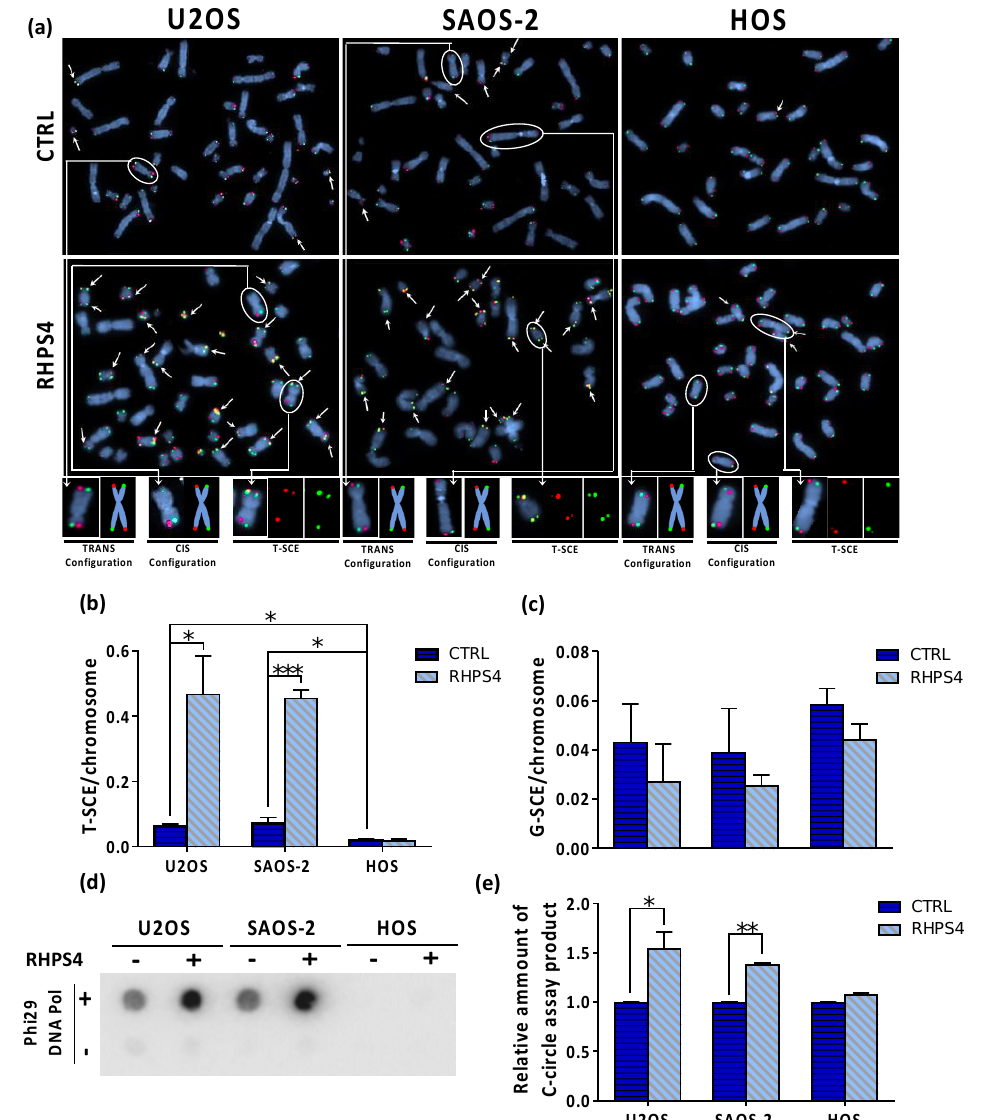
Figure 5. ( a ) Representative images of CO–FISH stained metaphases in U2OS, SAOS-2, and HOS osteosarcoma cell lines after RHPS4 treatment. Arrows indicate telomere sister chromatid exchanges (T-SCE). ( b ) Histograms show T-SCE frequency per chromosome end in osteosarcoma cell lines. RHPS4 treatment induced a significant increase of telomeric sister chromatid exchanges (T-SCE) in U2OS and SAOS-2 but not in HOS cells. ( c ) Genomic sister chromatid exchanges (G-SCE) in U2OS, SAOS-2, and HOS, determined using the method proposed by Cornforth and Eberle [46], are not modulated by RHPS4. ( d ) Dot blot analysis of c-circles in presence or absence of Phi29 DNA Pol enzyme in the indicated cell lines. ( e ) Densitometry of c-circles signals. For each cell line, the background value (-Phi29 DNA Pol sample) was subtracted and reported in histograms. Errors bars denote standard deviations. * p < 0.05, ** p < 0.01, *** p < 0.001 (Student’s t -test).